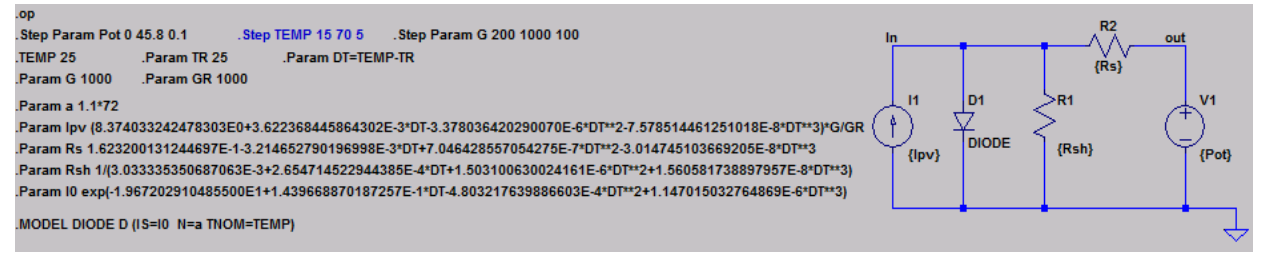
Figure 4. Equivalent circuit of MSP290AS-36.EU (multicrystalline).